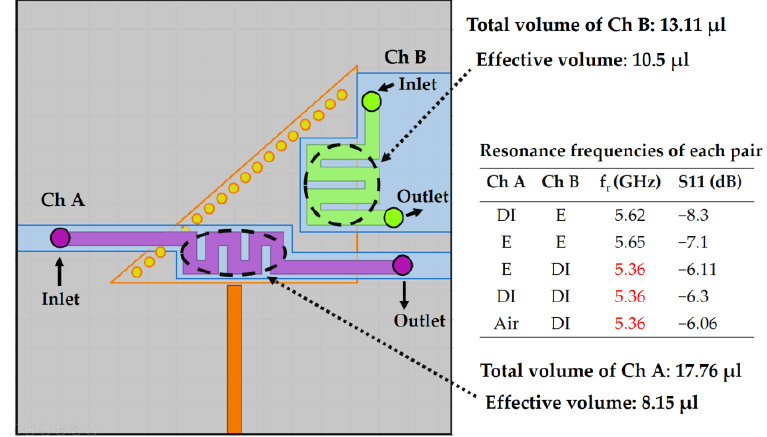
Figure 5. Simulation of two asymmetric channels, unable to produce a unique resonant frequency in each case, which can be explained by reasoning that the effective volumes (equivalent fluidic volume that overlaps with the strongest E-field) of the channels differ by a narrow margin. Although the channels are intentionally designed to be asymmetric, the effective permittivity is perturbed in a uniform way owing to the inadequate difference between the effective volume of channels: Ch A and Ch B. Therefore, different combinations of channel loadings—such as [E, DI], [DI, DI], and [Air, DI]—are observed to generate exactly the same resonance frequency. E and DI represent ethanol and deionized water, respectively.